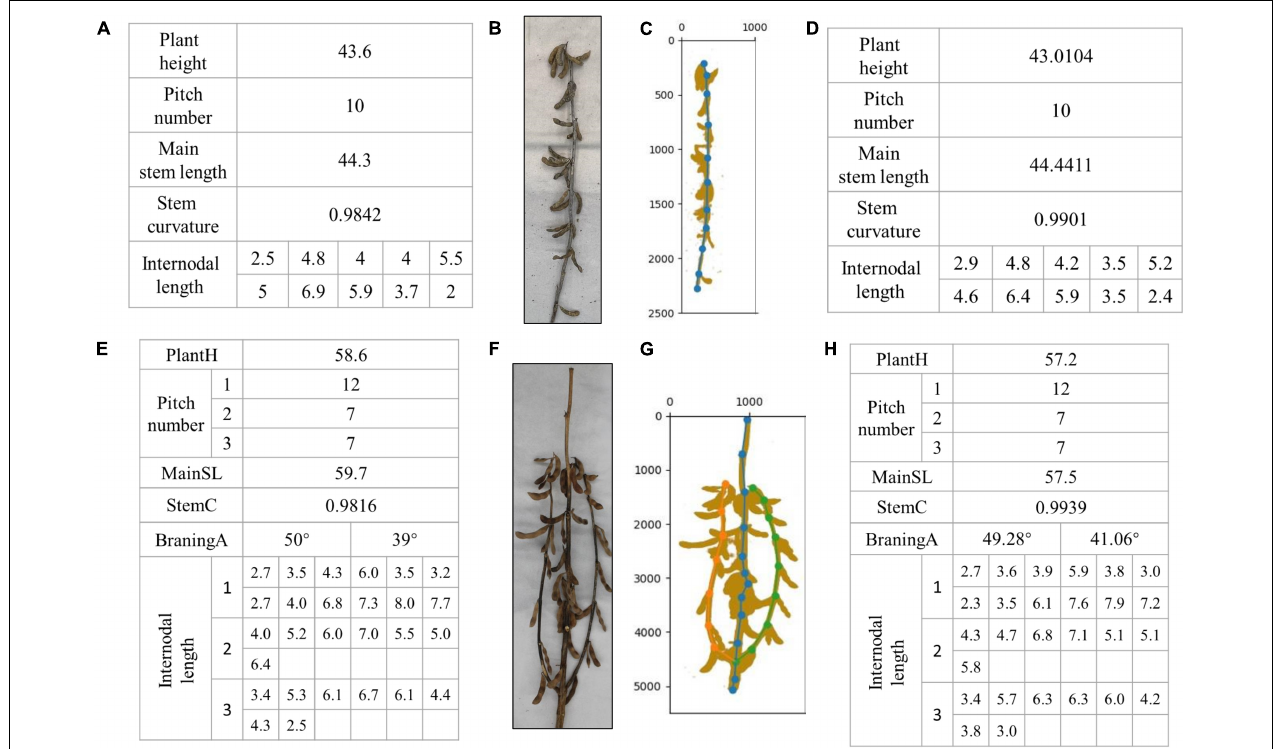
FIGURE 11 | Results of phenotype calculation and algorithm prediction of single-branch soybean plants and multi-branched soybean plants: (A–D) are branching-free soybean plants, and (E–H) are multi-branched soybean plants.